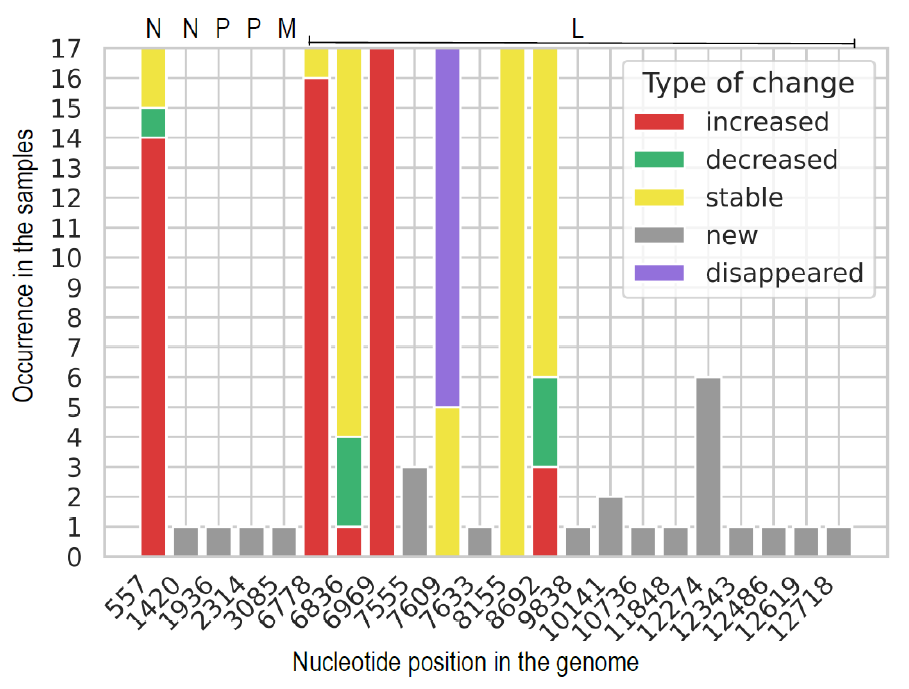
Figure 3. Changes in SNPs occurring in N, P, M, and L genes of SPBN GASGAS genome from P5 to P6 passage. Genomic position is indicated on X axis. Frequency of each SNP in samples from P6 was compared to P5 as basis, i.e., increased: P6 frequency > P5 frequency + 5% in P5, stable (±5% change in frequency), decreased: P6 frequency < P5 frequency — 5%, new: SNP occurring just in P6. Table 5. List of the 24 new SNPs in 6th SMB passage shown in Figures 2 and 3 as gray boxes, in Figure 3 for G genes, both genomic positions are indicated.